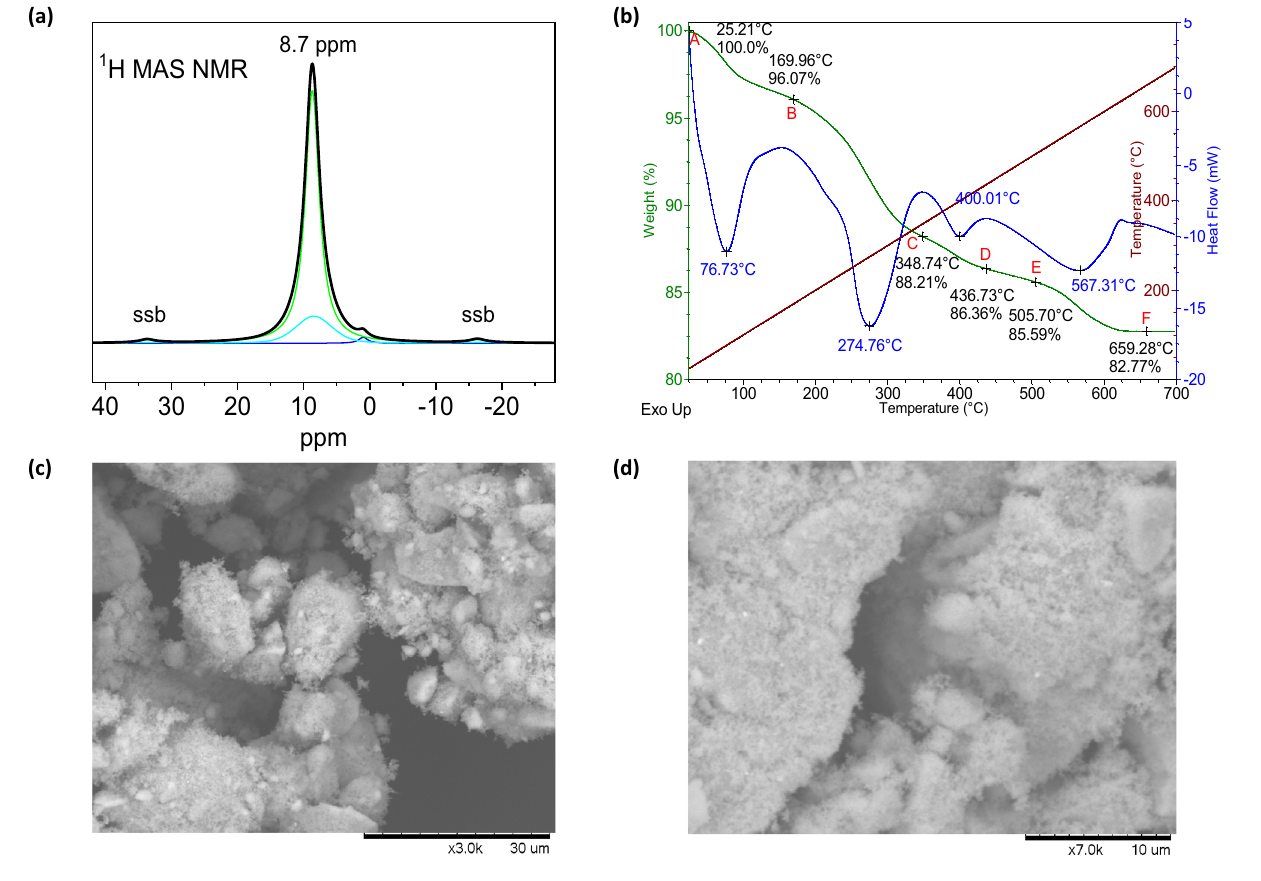
Figure 3. ( a ) 1 H MAS NMR deconvoluted spectrum, where three contributions can be identified: two corresponding to the H1 and H2 atoms at 8.70 ppm and 8.46 ppm, respectively, and a third, parasitic signal at 1 ppm coming from the rotor cap. The first two present higher chemical shifts than water molecules (5 ppm), accounting for the acidity of the protons of the sample. ( b ) TGA/DSC curves of the thermal analysis of the AA. Labels correspond to the stoichiometric formulae (A) (H 3 O) 1.20 H 0.77 Sb 2 O 6 ·0.703 H 2 O or Sb 2 O 5 ·2.89 H 2 O, (B)